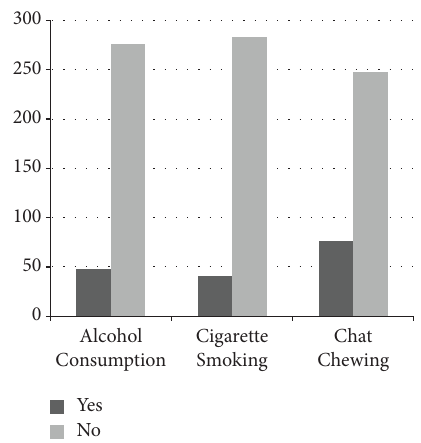
Figure 1: Te lifestyle of adult cancer patients undertaking